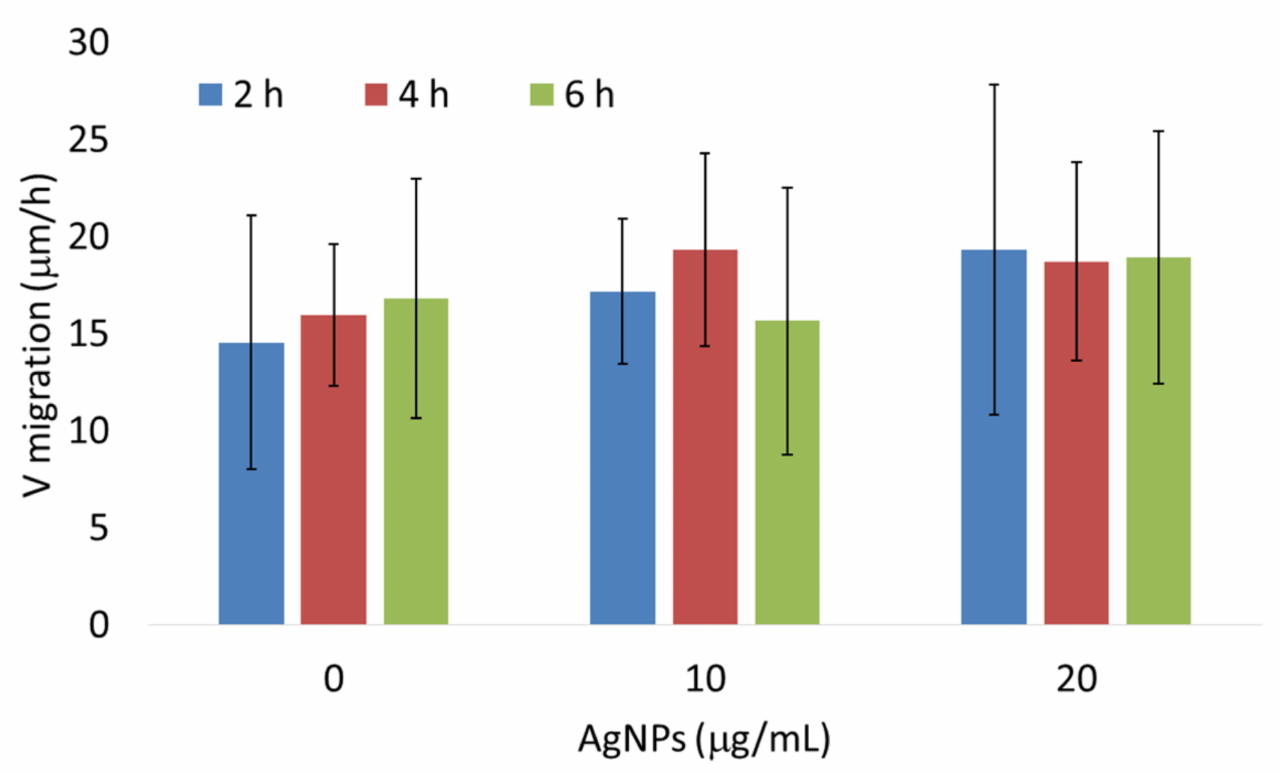
Figure 5. Citrate-coated AgNPs had no effect on 4T1 cell migration in vitro as measured by the wound healing assay. The data are presented as means and standard deviations from three independent experiments. The differences are not statistically